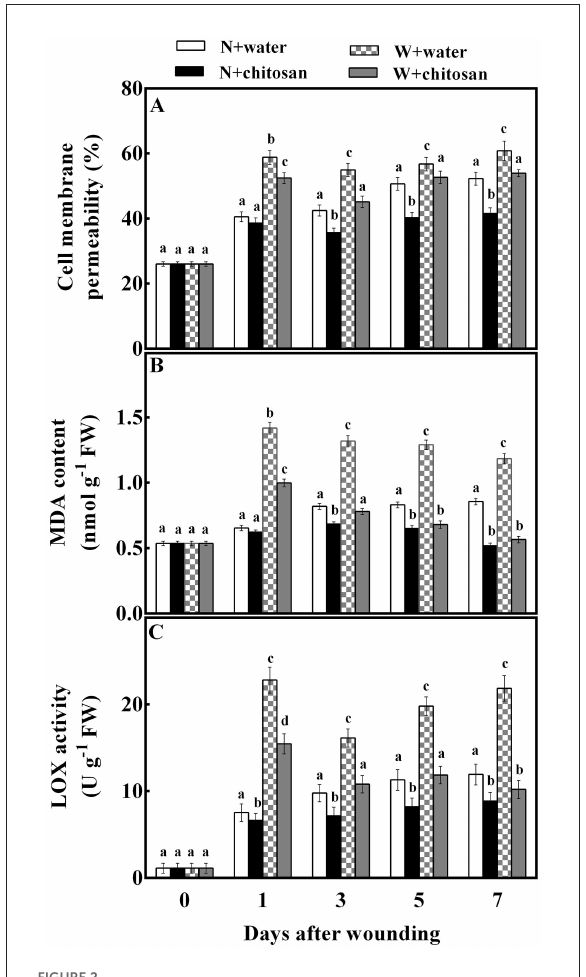
FIGURE2 Effect of chitosan treatment on cell membrane permeability (A) , MDA content (B) , and LOX activity at apple wounds (C) . Non-wounded fruit treated with sterile water (N + water), non-wounded fruit treated with chitosan (N + chitosan), wounded fruit treated with sterile water (W + water), and wounded fruit treated with chitosan (W + chitosan). Vertical bars indicate standard error of means. For each day after wounding, alphabets indicate significant differences ( P <